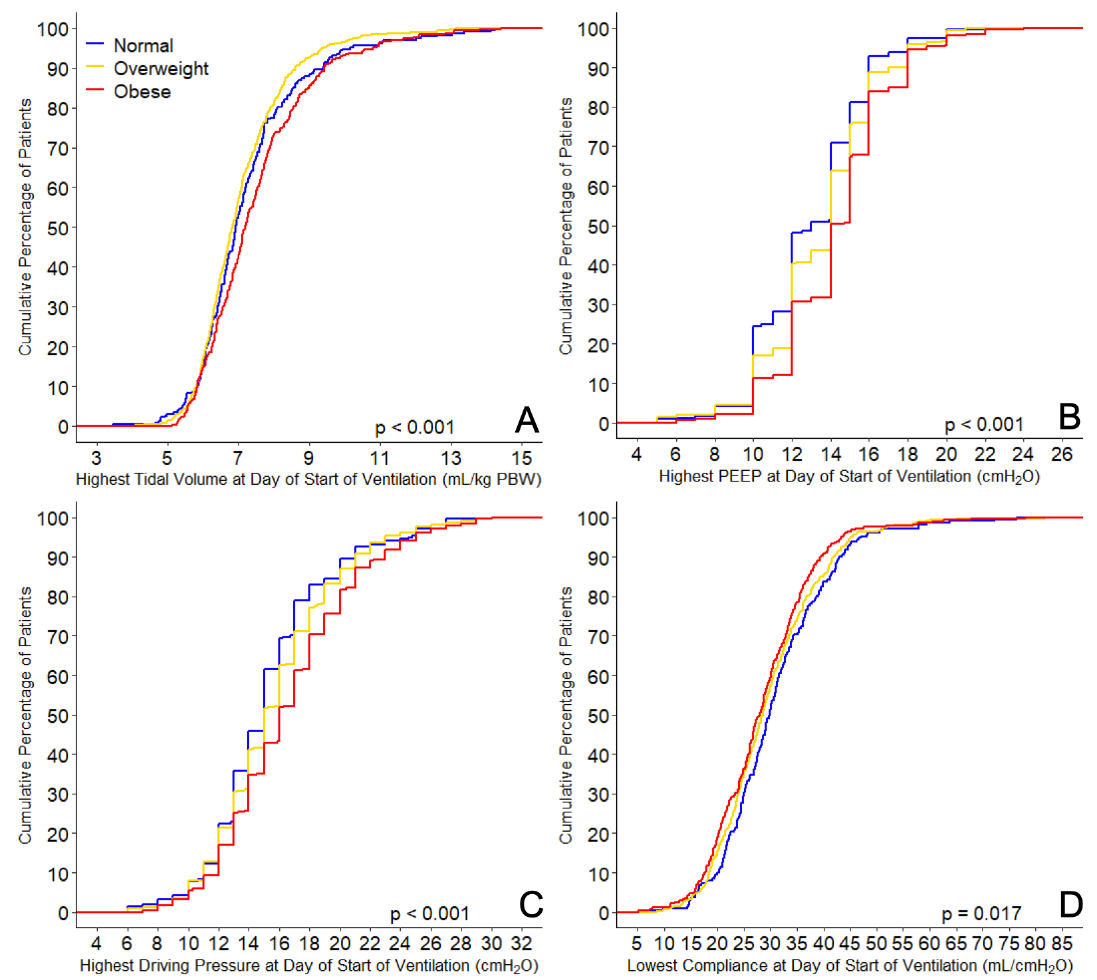
Figure 2. Ventilation parameters. Cumulative frequency distribution of ( A ) tidal volume, ( B ) positive end-expiratory pressure (PEEP), ( C ) driving pressure, and ( D ) respiratory system compliance. p values calculated from Kruskal–Wallis tests. In the first 4 days of ventilation, the use of alveolar recruitment maneuvers and prone positioning was not statistically different between the BMI categories (Table 2). Neuro- muscular blocking agents were more often administered in obese patients. Table 2. Clinical outcomes according to BMI category.